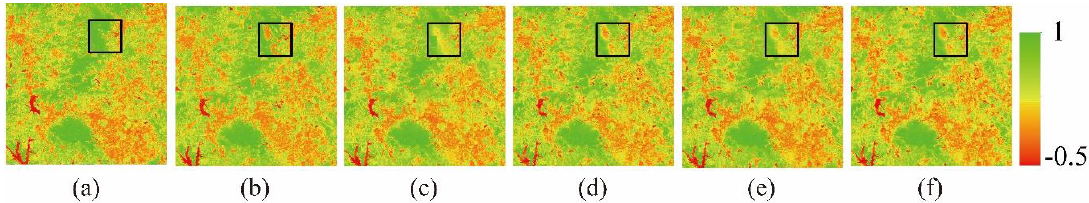
Figure 13. Visual comparison of urban area. ( a , b ). Original Landsat_NDVI on 1 November 2000 and 7 November 2002; ( c – f ). Predicted Landsat_NDVI by ESTARFM, NDVI-LMGM, FSDAF, and NDVI_FMHC.